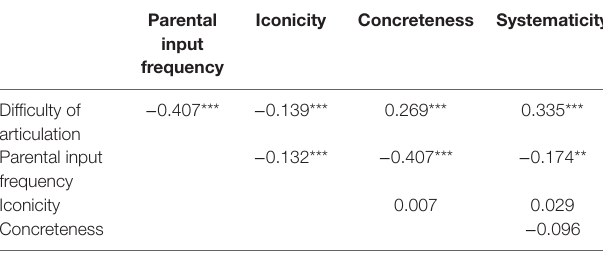
TaBle 3 | Pearson correlations among difficulty of articulation, parental input frequency, iconicity, concreteness, and